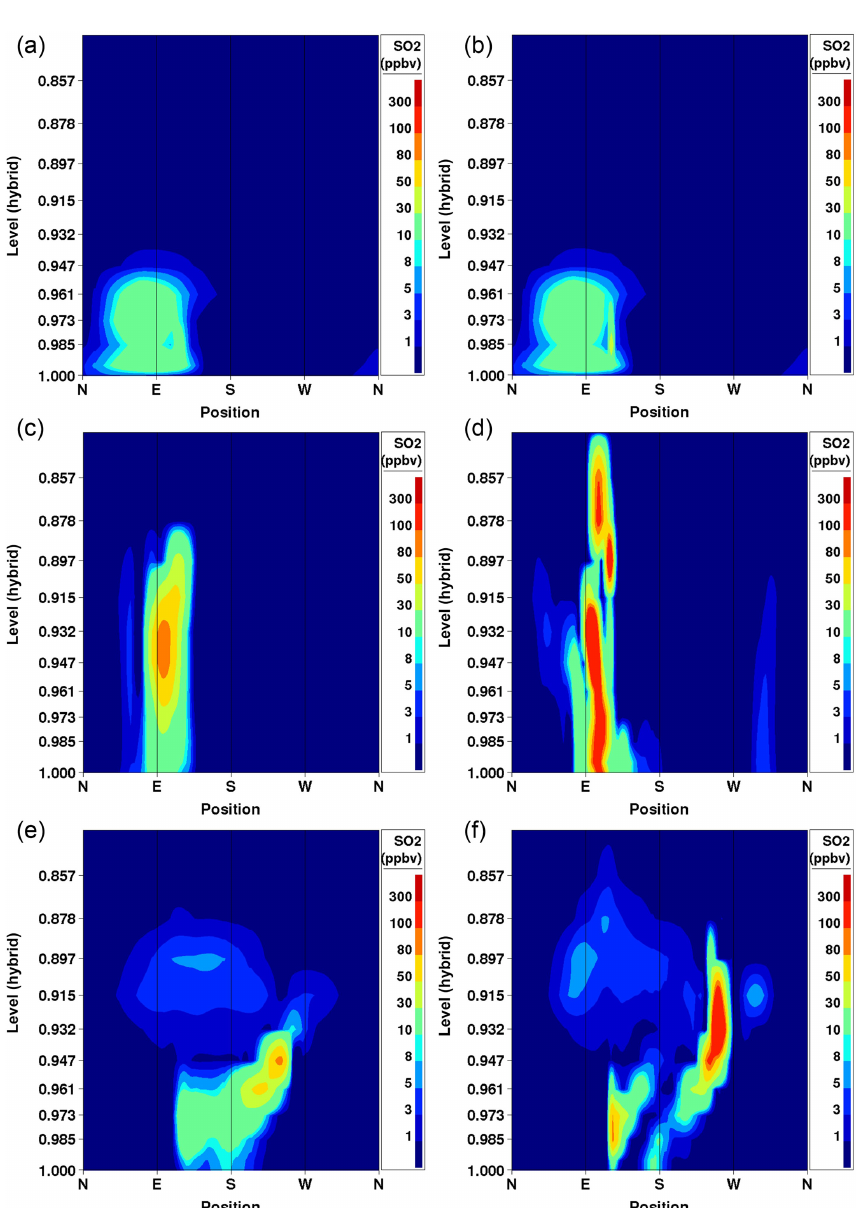
Figure 5. Comparison of simulated SO 2 plume mixing ratios (ppbv) located 0.2km from a major point source, for OS2.5km simulations (a, c, e) and OS1km simulations (b, d, f) , at 0 (a, b) , 12 (c, d) , and 24h (e, f) into a 24h